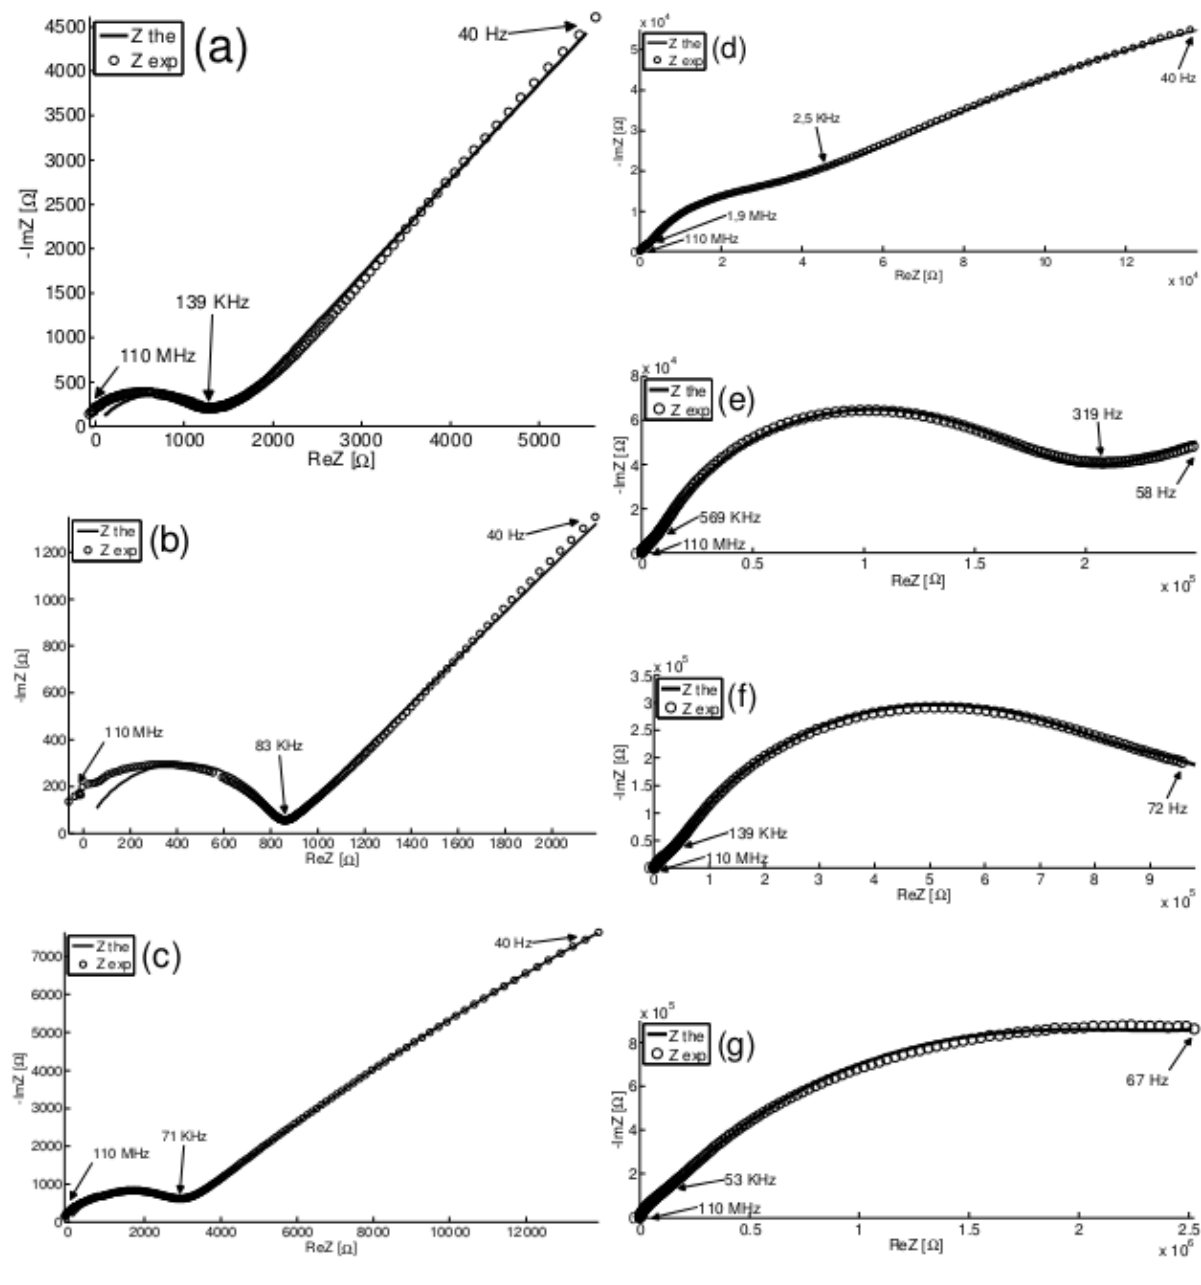
Figure 5: Experimental and modeled Nyquist plots for the different water saturation levels of type I cement paste; (a) S l = 0.973, (b) S l = 0.966, (c) S l = 0.88, (d) S l = 0.67, (e ) S l = 0.50, (f) S l = 0.30, (g) S l =